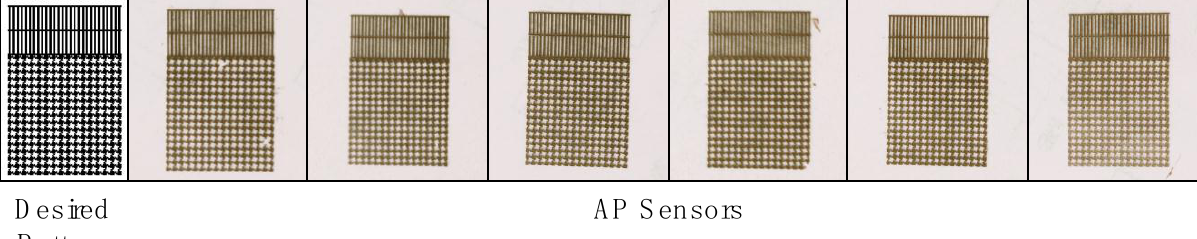
Figure 4. AP Sensor variability: ( Left ) desired sensor pattern and ( Right ) AP sensors consecutively peeled-off from same donor substrate. On average, AP sensors closely reflect the desired pattern, primarily because release rates in solvents pertaining to removal of sacrificial layer are not